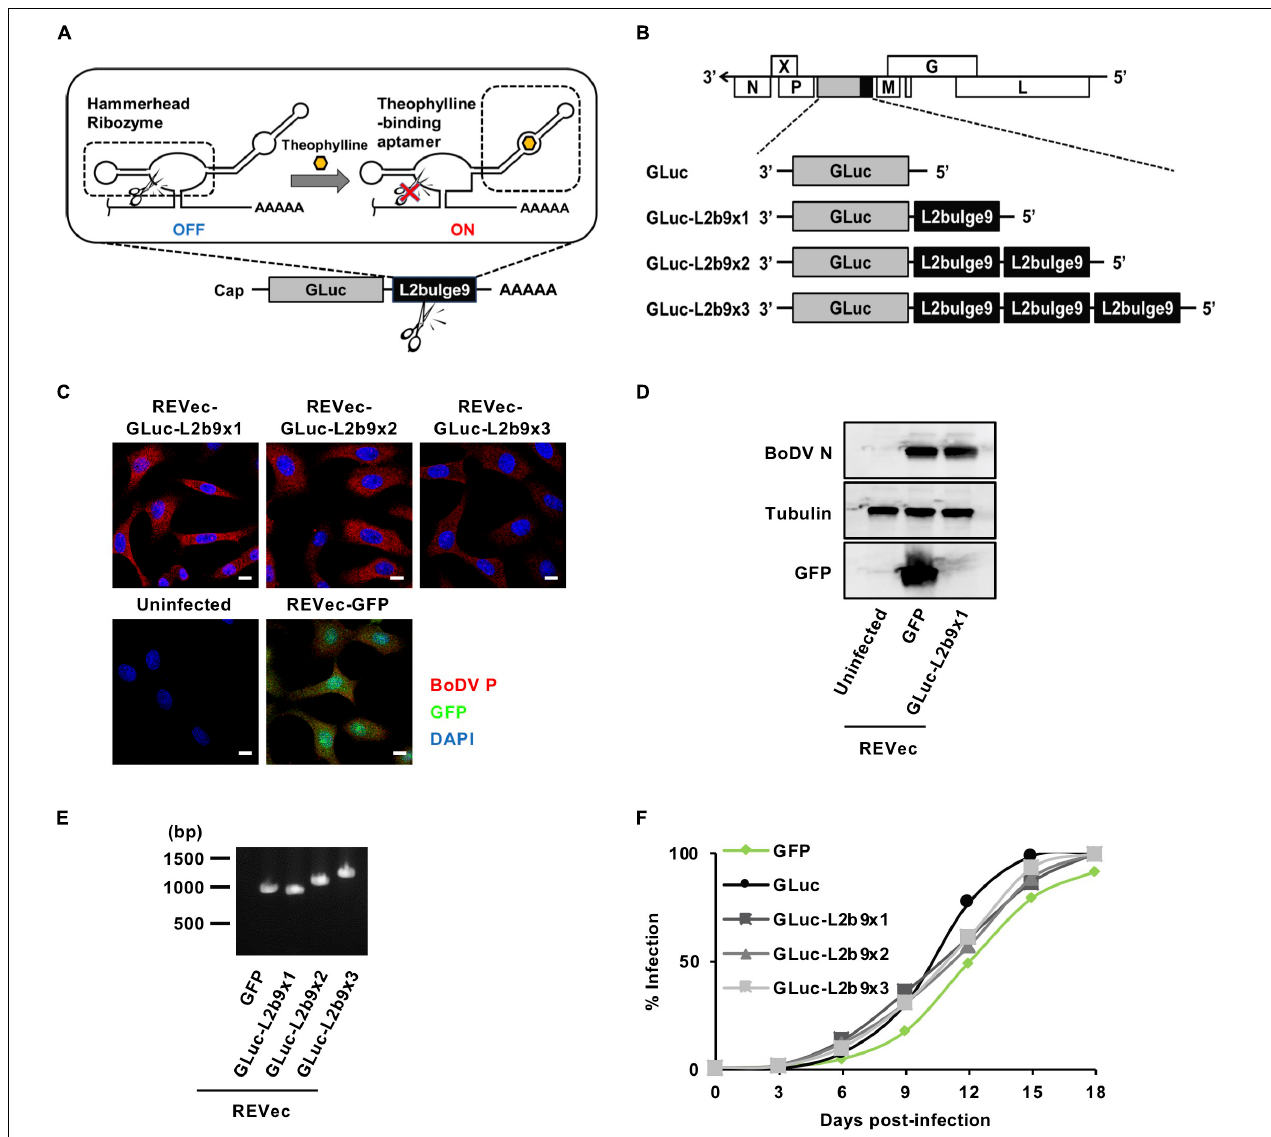
FIGURE 1 | Generation of REVec capable of controlling transgene expression. (A) Schematic diagram of L2b9. (B) Representation of the REVec-Gluc-L2b9 vector genomes. (C) IFA of established REVec-L2b9-infected Vero cells. Bars, 10 µ m. (D) N protein expression in established REVec-L2b9-infected cells. Lysates of REVec-L2b9-infected cells were subjected to western blotting using anti-N, anti-tubulin, and anti-GFP antibodies. (E) RT-PCR of the L2b9 cassette in REVec-L2b9. Copies of GLuc-L2b9 in each established REVec-L2b9 vector were detected by RT-PCR. (F) Growth kinetics of REVec-GFP, REVec-GLuc, and REVec-GLuc-L2b9s. Vero cells were de novo infected with REVecs at an MOI of 0.01, and the viral growth rate was monitored by